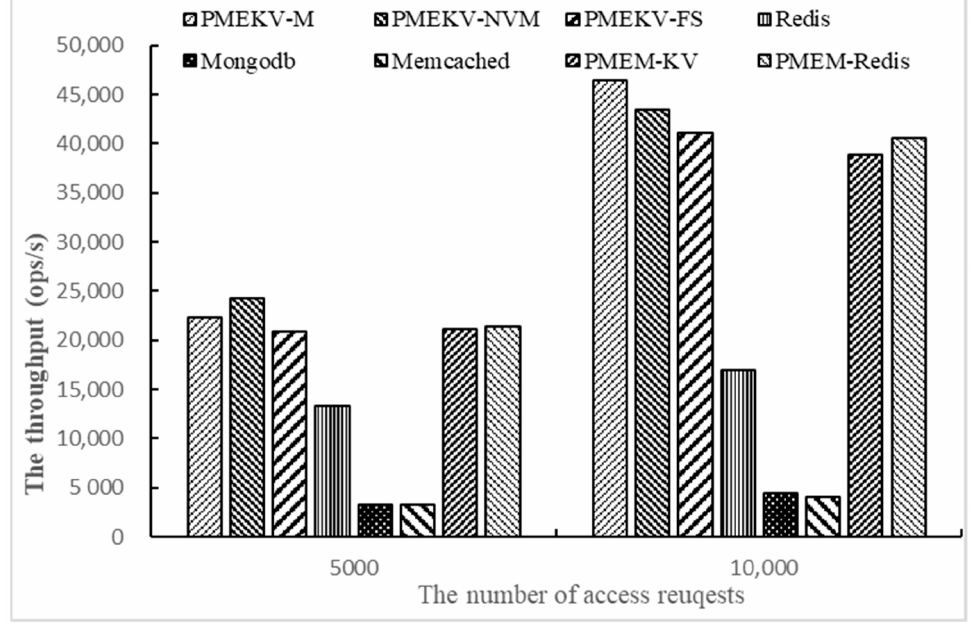
Figure 8. The throughput of changing the number of access requests on Workloada.